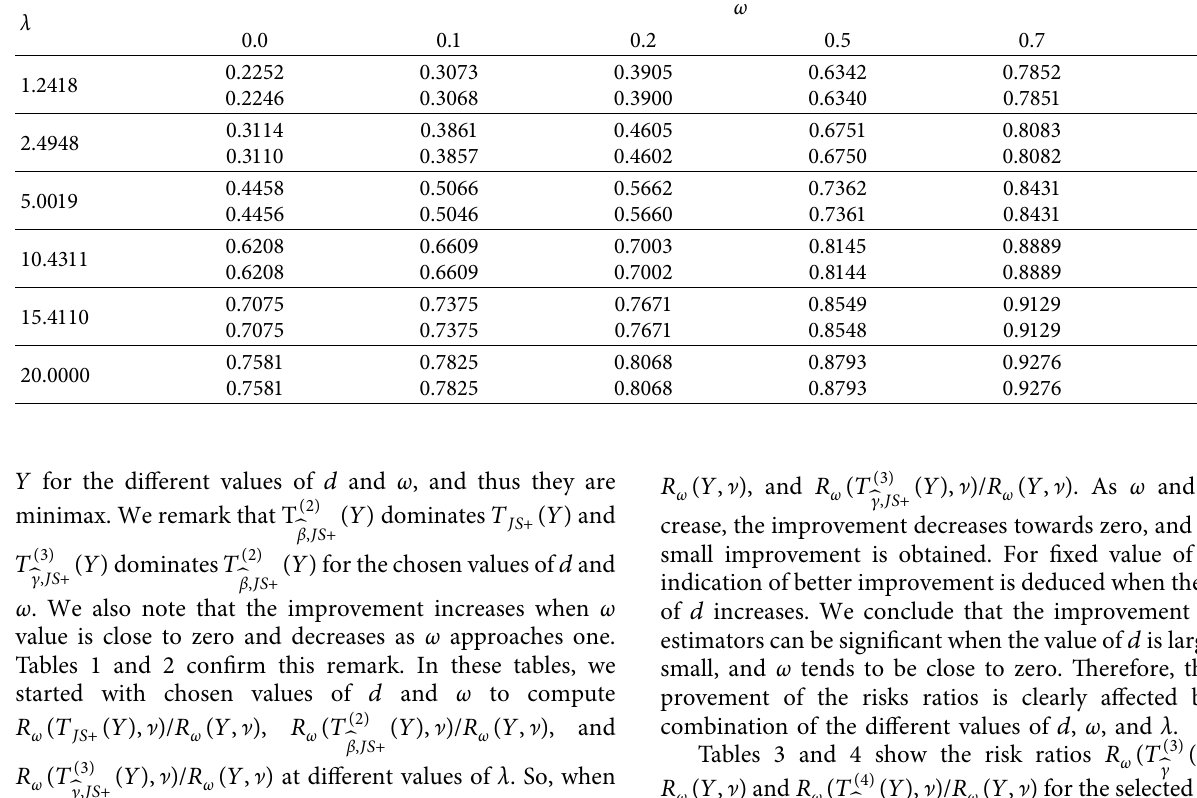
( T ( 4 ) (‖ Y ‖ 2 ) , ] ) / R 􏽢 ω δ ,JS +